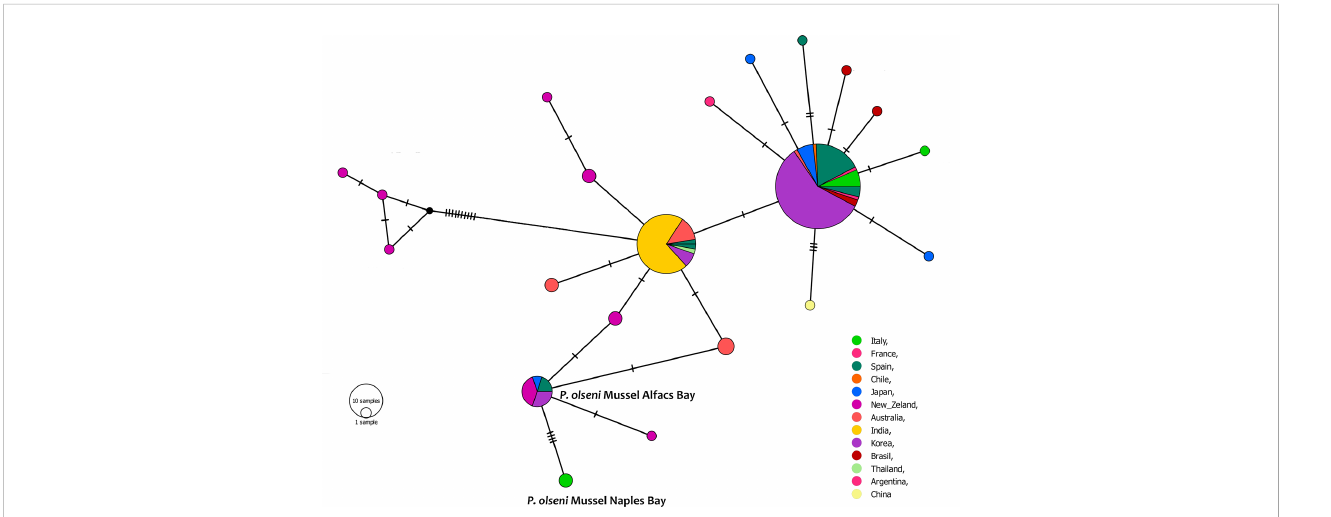
FIGURE 5 TCS network of 163 ITS1 haplotypes of Perkinsus olseni estimated by PopART. Each line between haplotypes indicates a single nucleotide substitution. The size of each circle is proportional to the absolute haplotype frequency, small black circles represent missing haplotypes, and color shows localities where each haplotype was observed.